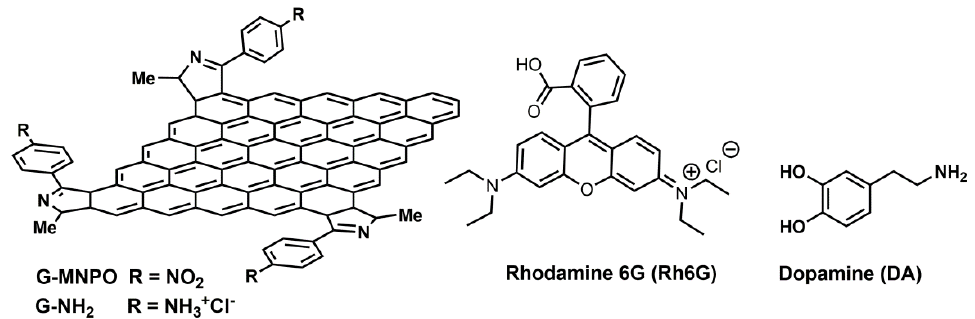
Figure 1. Schematic representation of G-MNPO and G-NH 2 . Chemical structure of Rhodamine 6G (Rh6G) and Dopamine (DA).